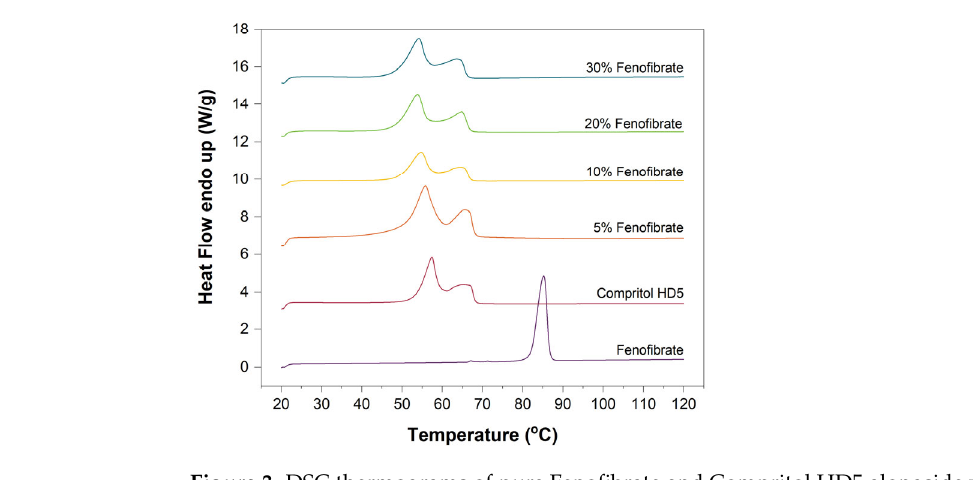
Figure 3. DSC thermograms of pure Fenofibrate and Compritol HD5 alongside with the ink mixture with increasing drug load (5%, 10%, 20% and 30% w / w ).